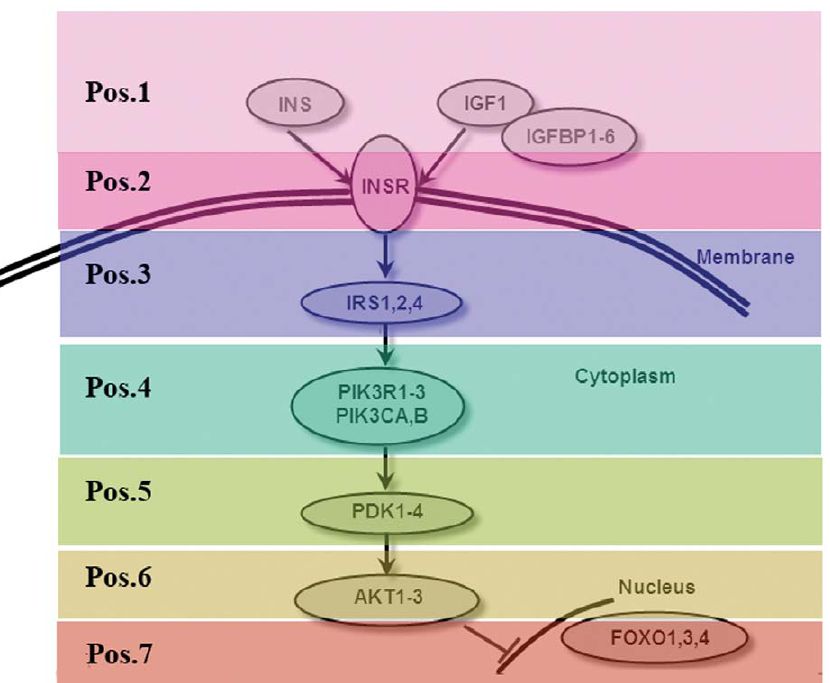
Figure 2. An illustration of the IGF1/FoxO pathway genes. Arrows indicate the direction of signal transduction. The numbers on the left side represent the position of the IGF1/FoxO pathway genes.